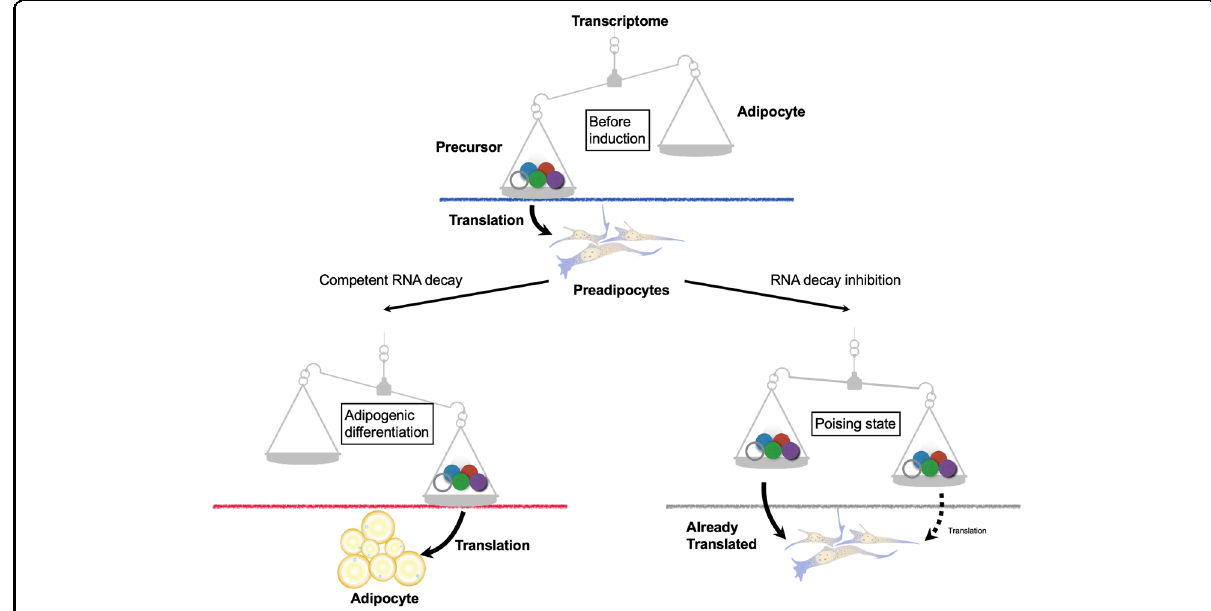
Fig. 7 Model of adipogenic differentiation relevant to RNA